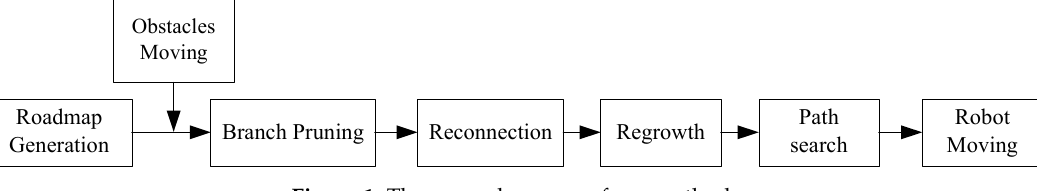
Figure 1. The general process of our